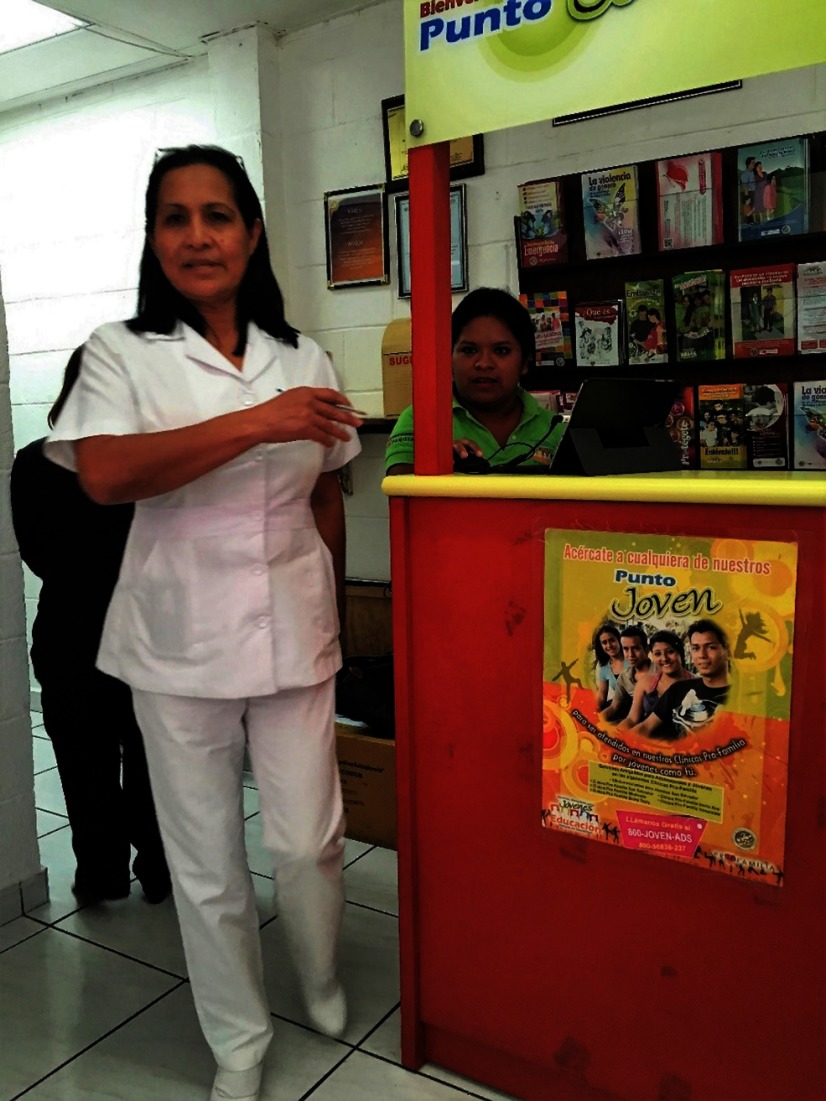
In El Salvador, a clinic supervisor and youth peer promoter tend a kiosk where the Net Promoter Score survey is set up for clients to provide feedback. © 2017 Moira Mendoza/International Planned Parenthood Federation/Western Hemisphere Region